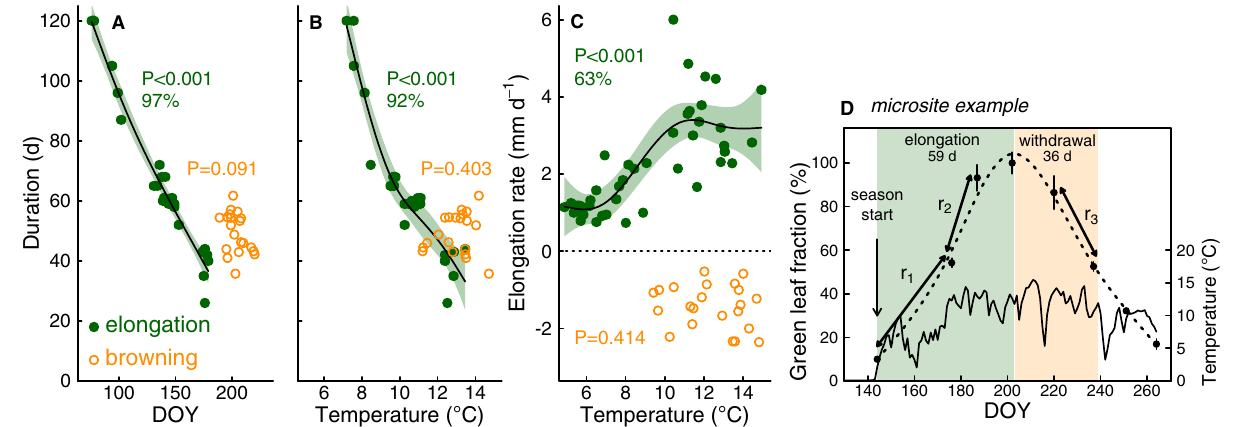
Fig. 5 | Duration and rates ofgrowth and senescence in microsites (2020). Leaf elongation (green) and browning (orange) duration of Carex curvula related to A the onset of the respective period ( n =24 microsites for elongation and 20 for browning) and B to meansoil/meristem temperature( n =23 for elongationand 20 forbrowning). C Dailyratesofelongationandbrowning(negative)inrelationtosoil temperature ( n =43 measurement intervals for elongation and 22 for browning). D Exemplary data from one microsite illustrate how values in A – C were derived: